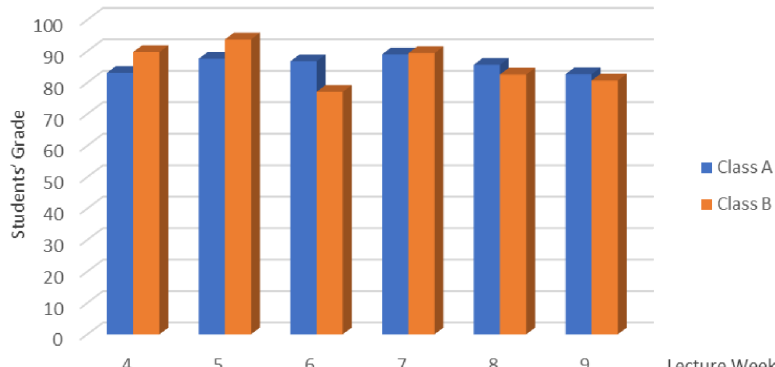
Figure 5. Students’ grade means per class for quasi-experiment